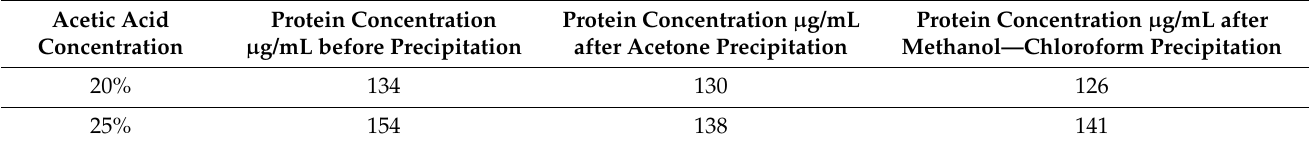
Table 2. Protein concentration before and after acetone or methanol ‐ chloroform precipitation.